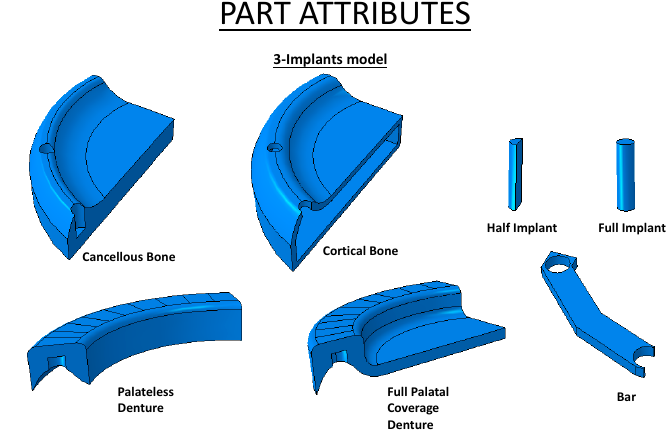
Appl. Sci. 2020 , 10 , x FOR PEER REVIEW Figure 4. Part attributes for the FEA three-implant models. Figure 4. Part attributes for the FEA three-implant models.